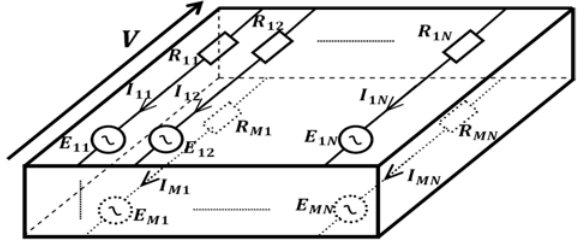
Figure 4: Model for the evaluation of emf and currents induced inside the sane conducting